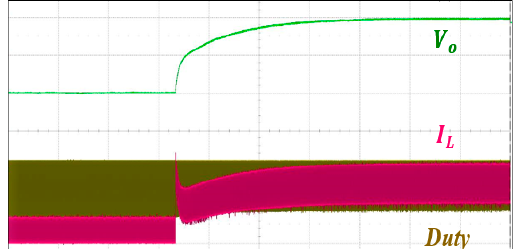
Figure 24. Inductor current waveform when the output voltage is raised in the proposed hybrid current mode control. (10 V/div, 1 A/div, 50 ms/div).